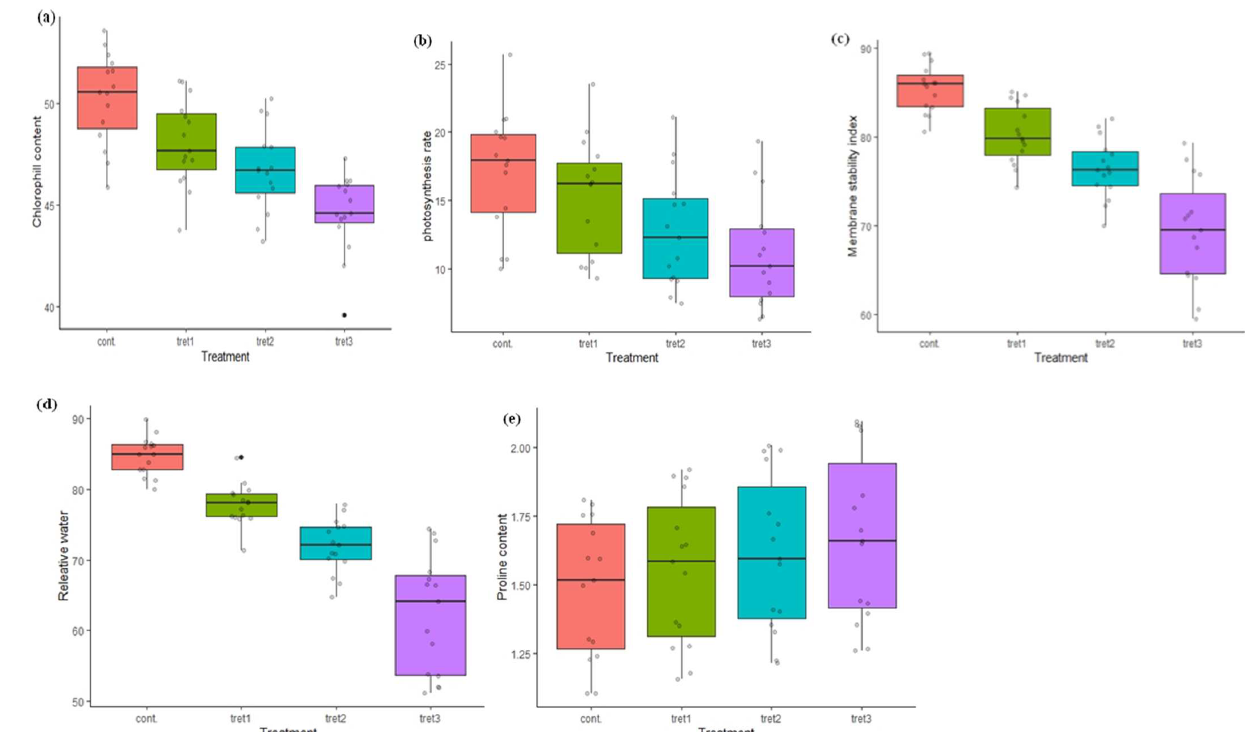
Figure 2. Variation in physiological and biochemical traits in Control (0% PEG), 5% PEG, 10% PEG and 15% PEG treatment conditions: ( a ) Chlorophyll content, ( b ) Photosynthesis rate, ( c ) Membrane stability index, ( d ) Relative water content, ( e ) Proline content.